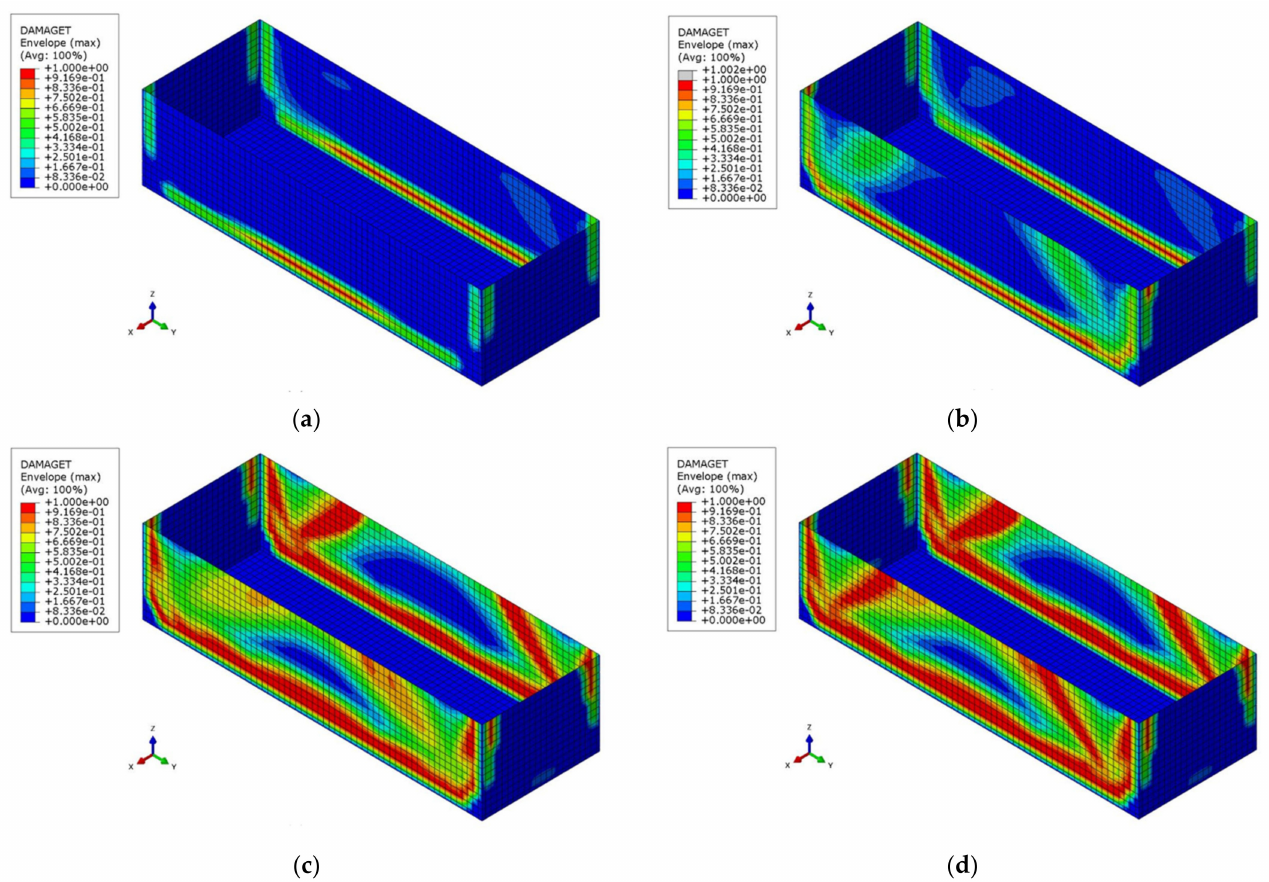
Figure 6. Tensile damage variable d t when the incident angle of the input ground motion is zero: ( a ) 1.51 s; ( b ) 1.91 s; ( c ) 2.60 s; ( d ) 9.46